Question: In one sentence, what is this figure communicating?
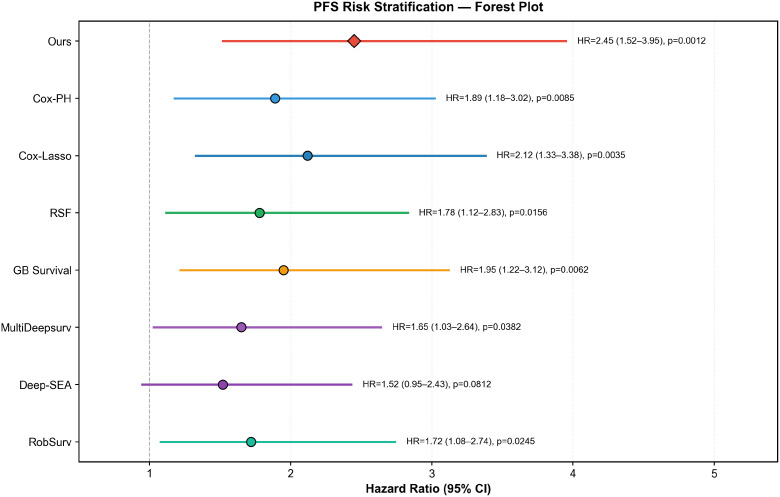
Answer: Forest plot of hazard ratios (95% CI) for progression-free survival across evaluated methods.